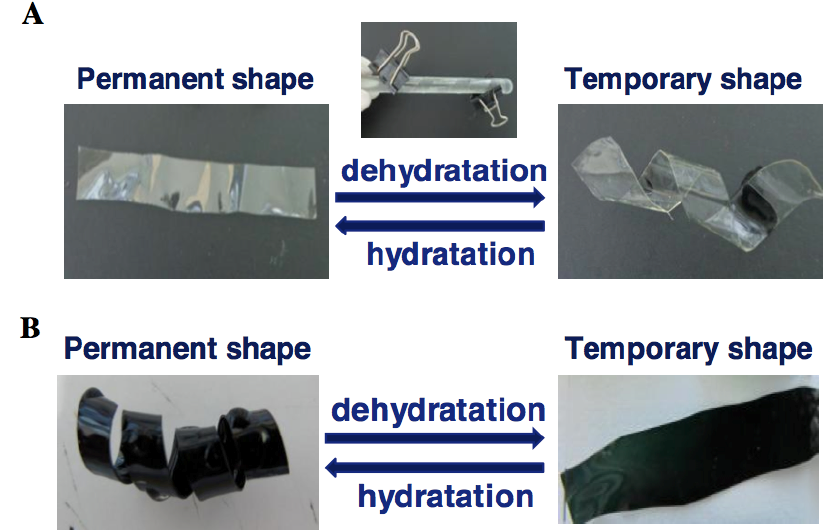
Figure 4. ( A ) Photographs of the permanent and temporary shapes of the pure CHT membranes. ( B ) Photographs of the permanent and temporary shapes of the genipin crosslinked CHT